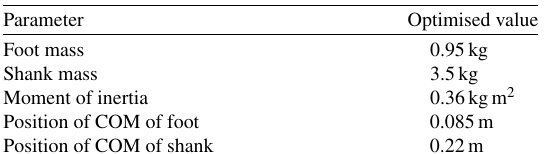
Fig. 6. Responses of the pendulum test and the model. Table 4 Optimised value of anthropometric inertia